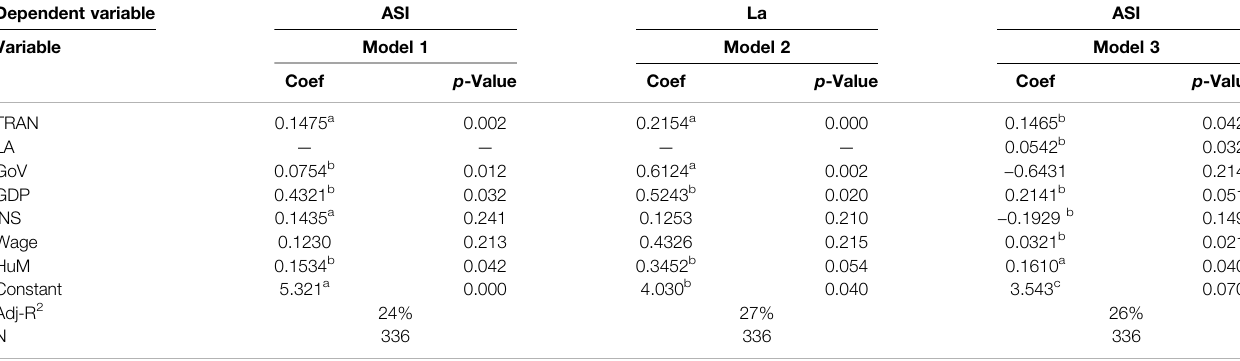
TABLE 2 | The relationship between urban rail transit on industrial agglomeration: mediating effect of labour agglomeration. Dependent variable ASI La ASI Variable